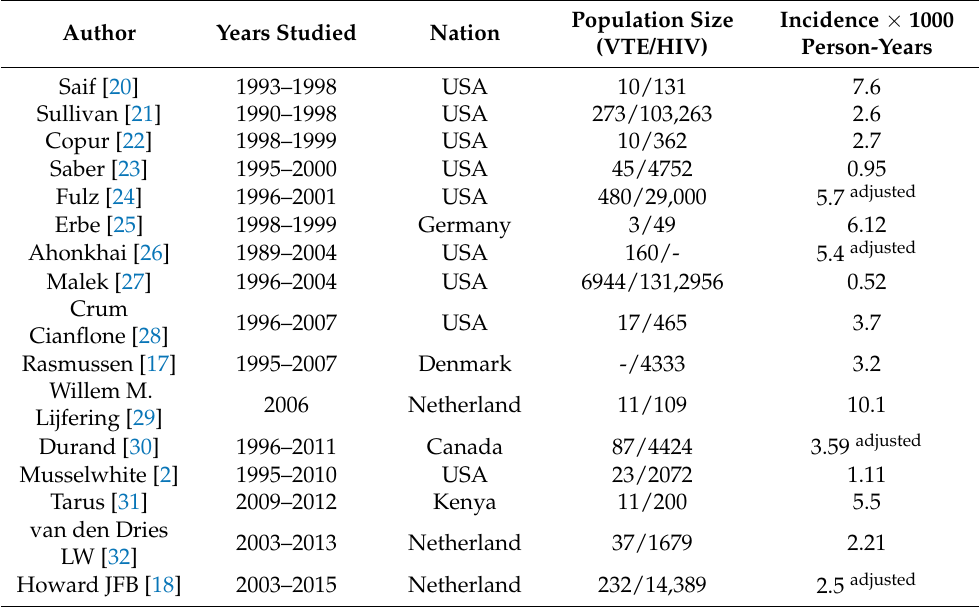
Table 1. VTE incidence in patients with HIV infection in different